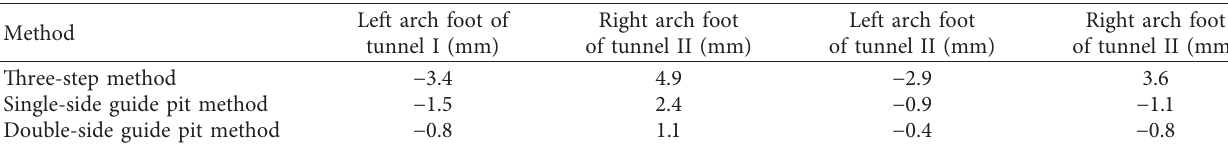
Figure 34: Displacement of the vault of tunnel I. Table 7: Horizontal displacement of surrounding